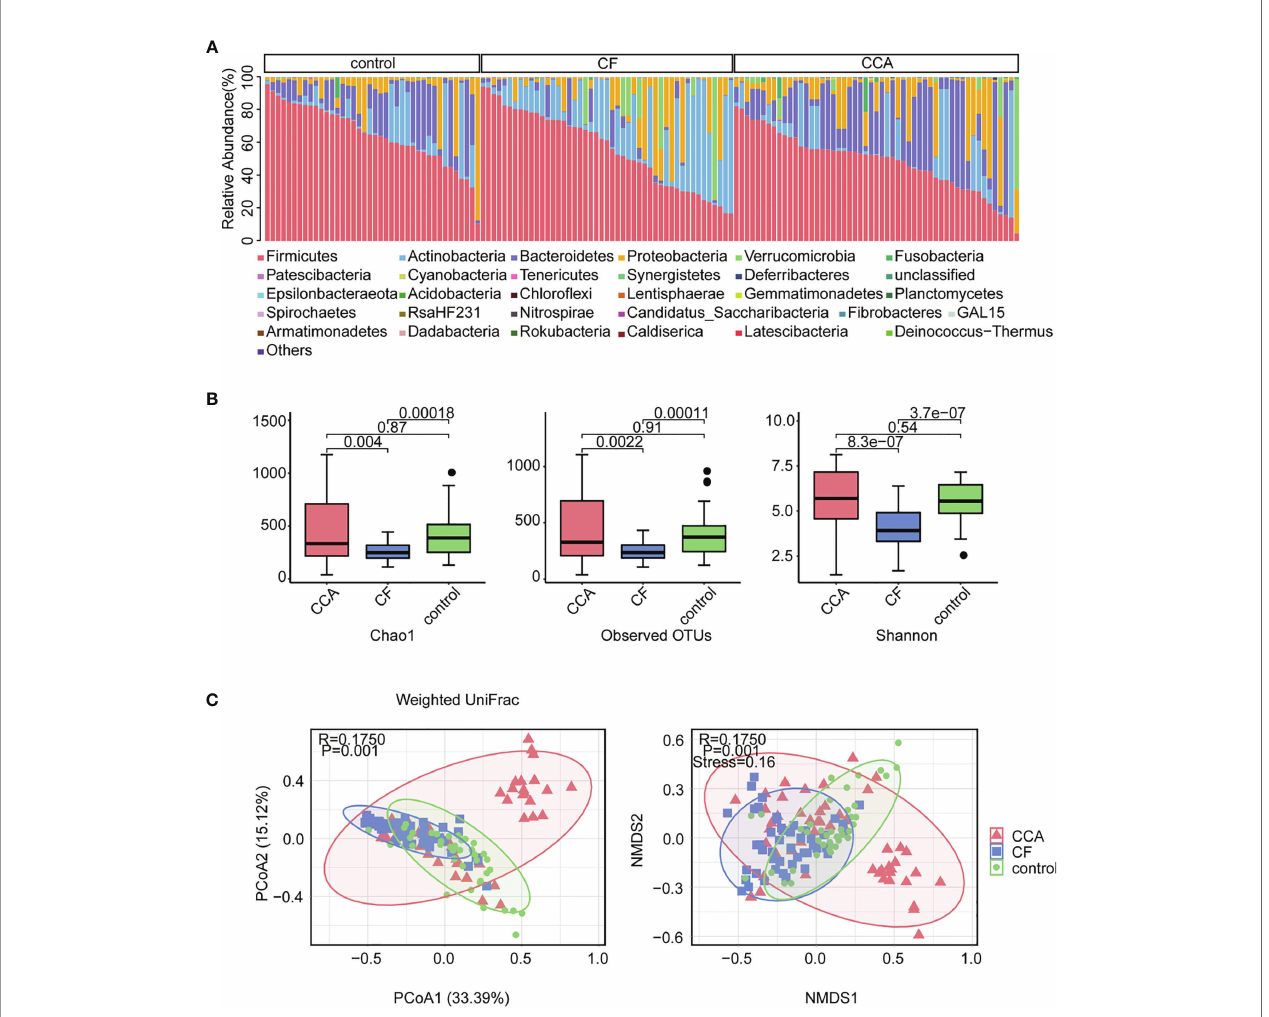
FIGURE 1 | Abundanceandbiodiversityofgutmicrobiotaincontrol(n= 40),cholelithiasis [cancer-free(CF)] (n=47), andcholangiocarcinoma(CCA)(n= 53). (A) Relative abundancecomparisons ofthedominantbacteriainphylum levelamongcontrol,CF,andCCA. (B) Chao1, operationaltaxonomicunits(OTUs), andShannondiversityindex in thethreecohortswere shownwithboxplot. Theboxrepresentedtheinterquartilerange, andthemidlineintheboxrepresentedthemedian. (C) Non-metricmultidimensional scaling(NMDS)index andprincipalcoordinatesanalysis(PCoA)basedonweightedUniFracdistance metricofcontrol, CF,andCCA(P= 0.001, P= 0.001,